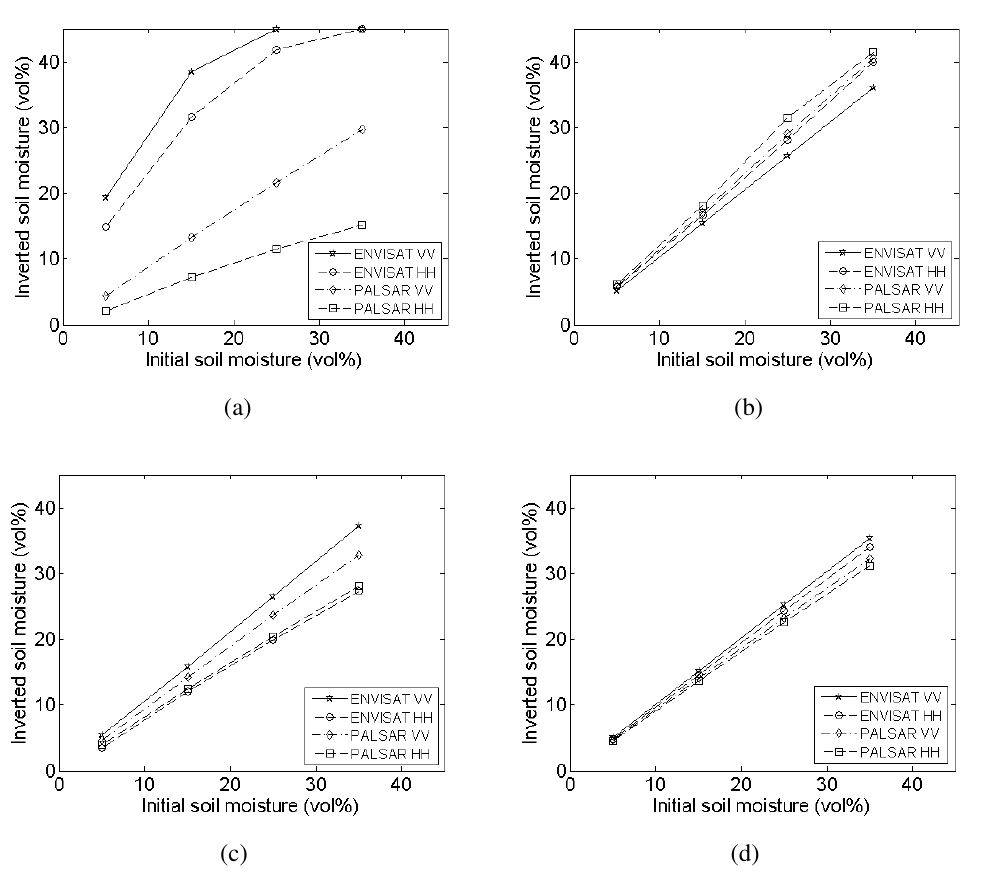
Figure 15. Mean inverted soil moisture contents for different radar configurations, using roughness parameters obtained after (a) linear detrending over the 4-m profile, (b) piecewise 1-m detrending, (c) second-order polynomial detrending and (d) third-order polynomial de- trending of 10 synthetical roughness profiles of ( s , l ) = (1 cm,5 cm) with added cosine